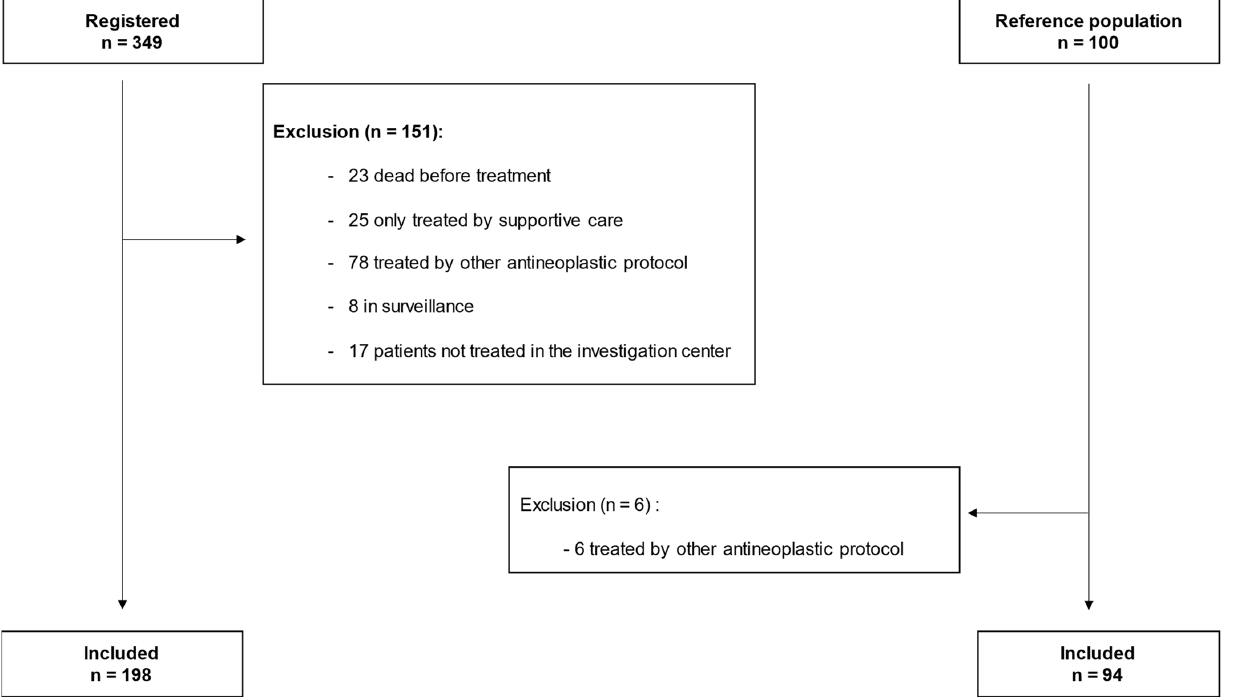
Figure 1. Flow chart of the study. n : number. Clinical and treatment characteristics of the 292 included patients are described in Table 1. No difference in baseline characteristics was found for gender, anthropometric indicators (weight, height, and BMI), estimated glomerular filtration rate, performance status, and tumour location. However, the two groups’ ages, treatment types, and chem- otherapy protocols were statistically different. Table 1. Clinical characteristics of the patients. Characteristic